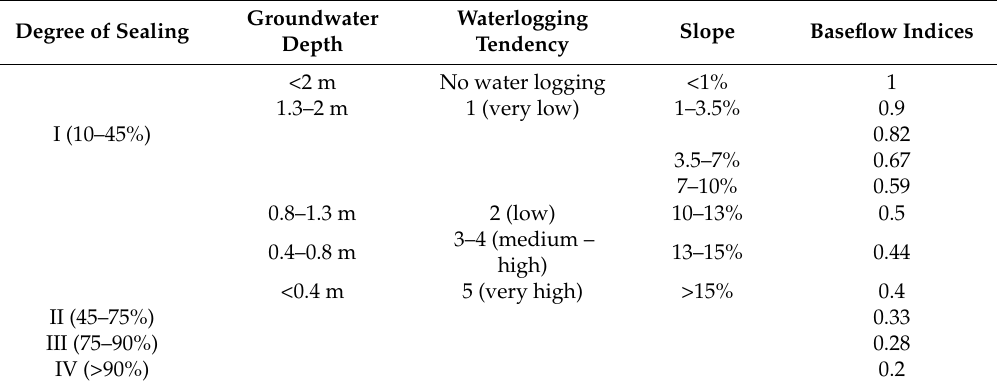
Table 1. Base flow index (BFI) values of the unconsolidated rock areas according to Dörhöfer and Josopait (1980) [31], Hennings (2000) [32], and Wessolek and Facklam (1997) [33].